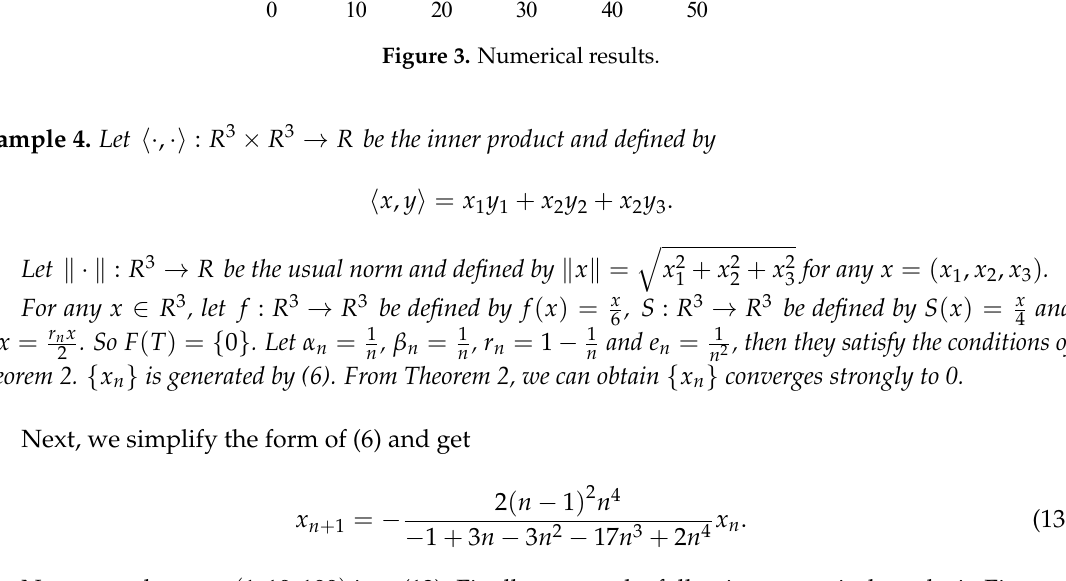
Figure 3. Numerical results.